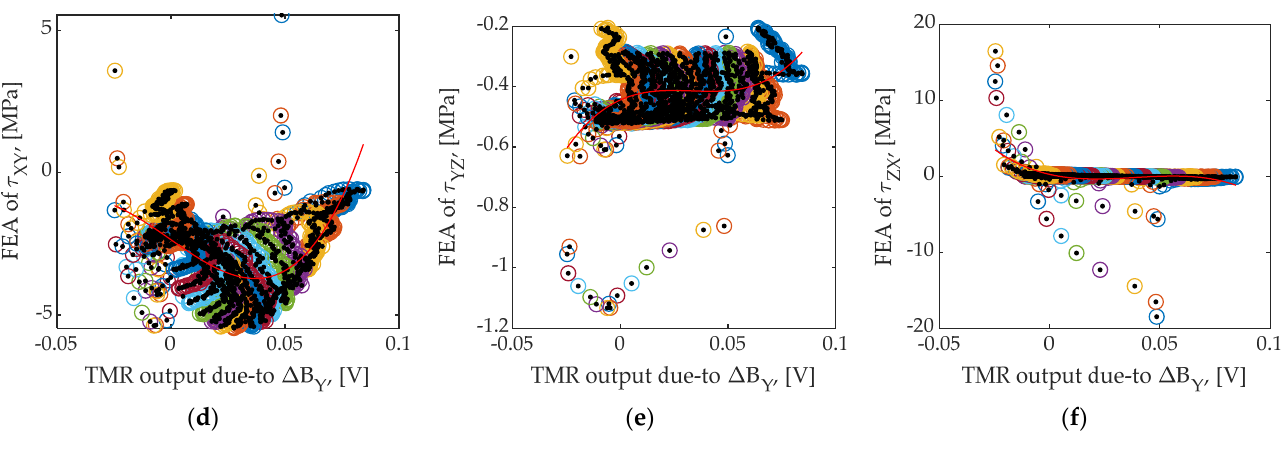
Figure 9. FEM analysis versus experimental results of the differential magnetic flux density ( ∆ B Y ) on the area of interest: ( a ) FEM analysis of σ X vs. ∆ B Y ; ( b ) FEM analysis of σ Y vs. ∆ B Y ; ( c ) FEM analysis of σ Z vs. ∆ B Y ; ( d ) FEM analysis of τ XY vs. ∆ B Y ; ( e ) FEM analysis of τ YZ vs. ∆ B Y ; ( f ) FEM analysis of τ ZX vs. ∆ B Y .